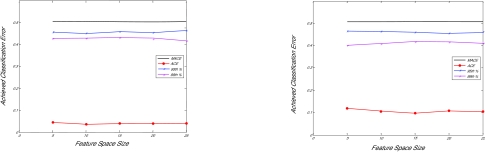
PACE analysis using a SVM-based classifier using the Fisher scoring criterion, with a 0.6 MAC threshold. Left Panel: performance without peak selection. Right panel: performance with peak selection.